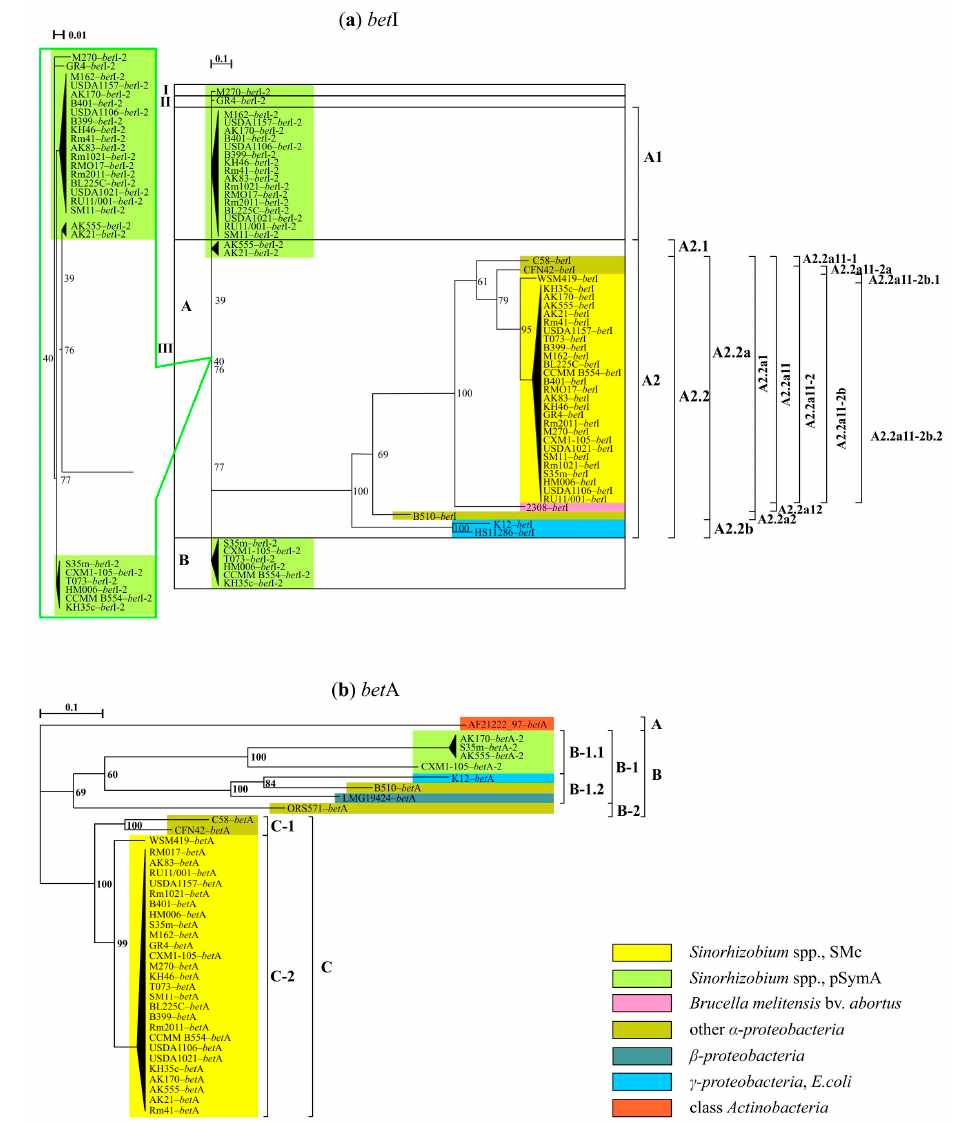
Figure 5. Phylogenetic analysis of bet I ( a ) and bet A ( b ) genes in α -, β - and γ -proteobacteria, as well as Actinobacteria . The nucleotide substitution models selected for the analysis were TPM3u + F + G4 for bet I and GTR + F + G4 for bet A sequences. The scale bars were 0.1 for bet I and bet A nucleotide substitutions per site.